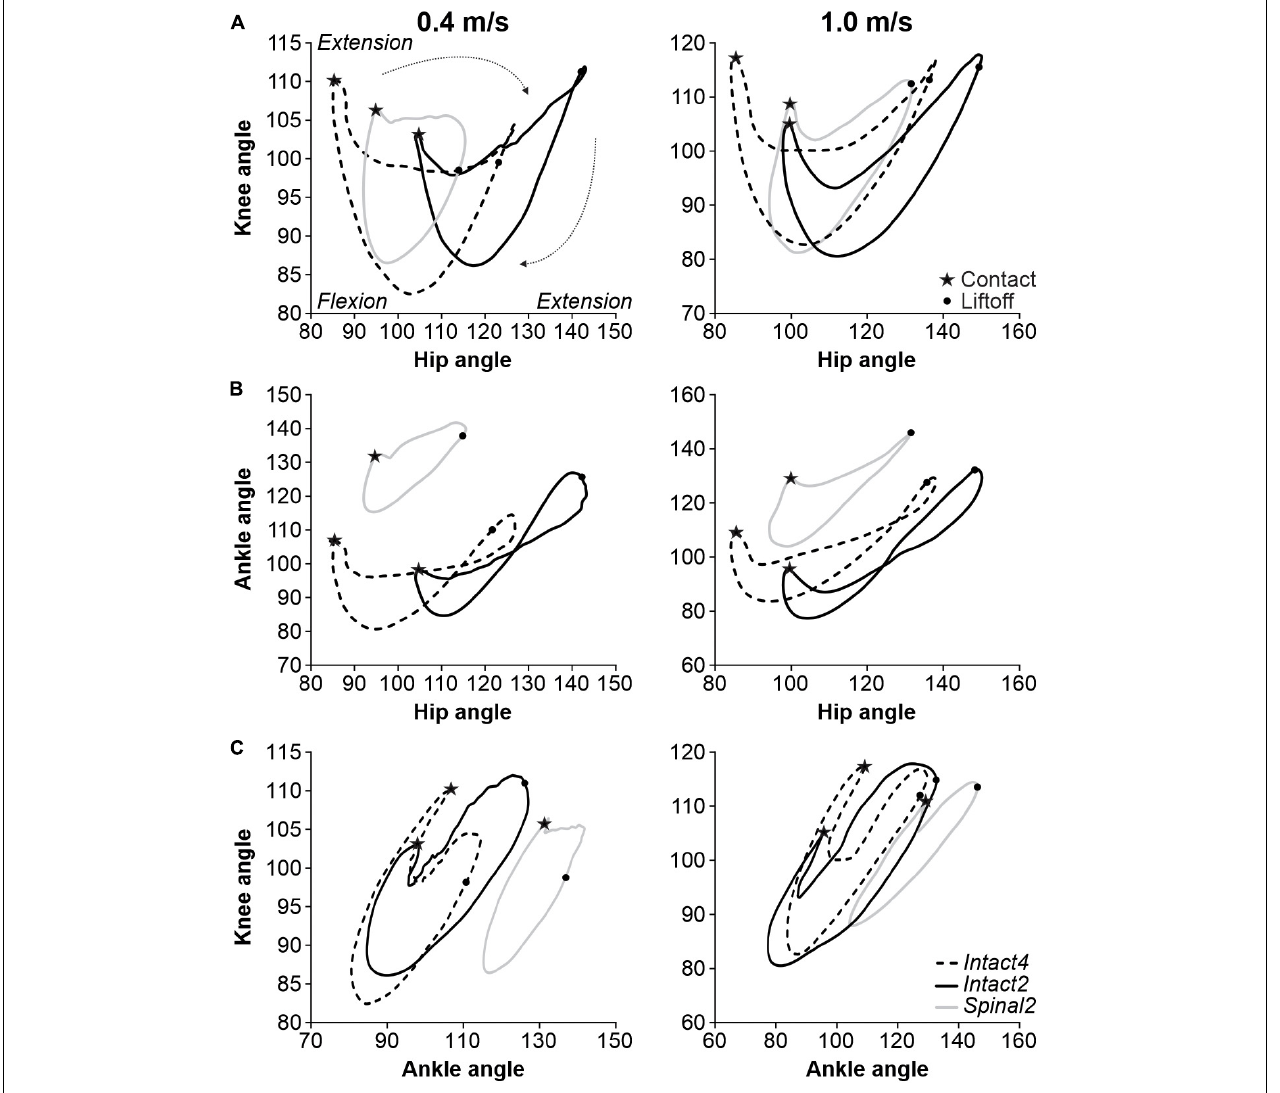
FIGURE 4 | Interjoint coordination during quadrupedal or hindlimb-only locomotion in intact and spinal cats across speeds. (A) Knee-hip, (B) Ankle-Hip and (C) Knee-ankle cyclograms during Intact4, Intact2 and Spinal2 conditions at 0.4 and 1.0 m/s. In panels (A–C) and at each speed, 6–15 cycles were averaged per cat. Each line is the mean for the group ( n = 9 cats). Contact and liftoff are indicated by a star and a dot, respectively. The arrows around the cyclograms indicate the direction of time progression in a clockwise